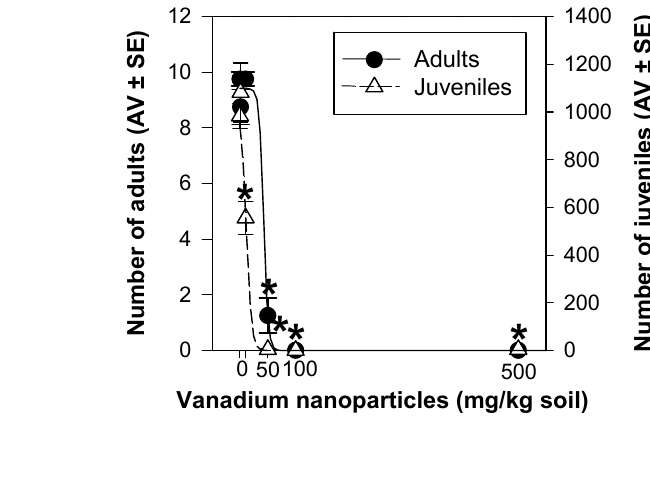
Figure 3. Effects of boron nanoparticles ( A ) and vanadium nanoparticles ( B ) spiked LUFA 2.2 soil on survival (number of adults) and reproduction (number of juveniles) of Enchytraeus crypticus after 28 days. Results are expressed as average value (AV) ± standard error (SE) (n = 4). Lines represent the models fit to data. * Significant differences to control ( p < 0.05). After 56 d, both NPs, at 100 and 500 mg/kg, decreased the E. crypticus reproduction ( p < 0.05; Figure 4A,B). VNPs also decreased the reproduction at 50 mg/kg ( p < 0.05; Figure 4B).